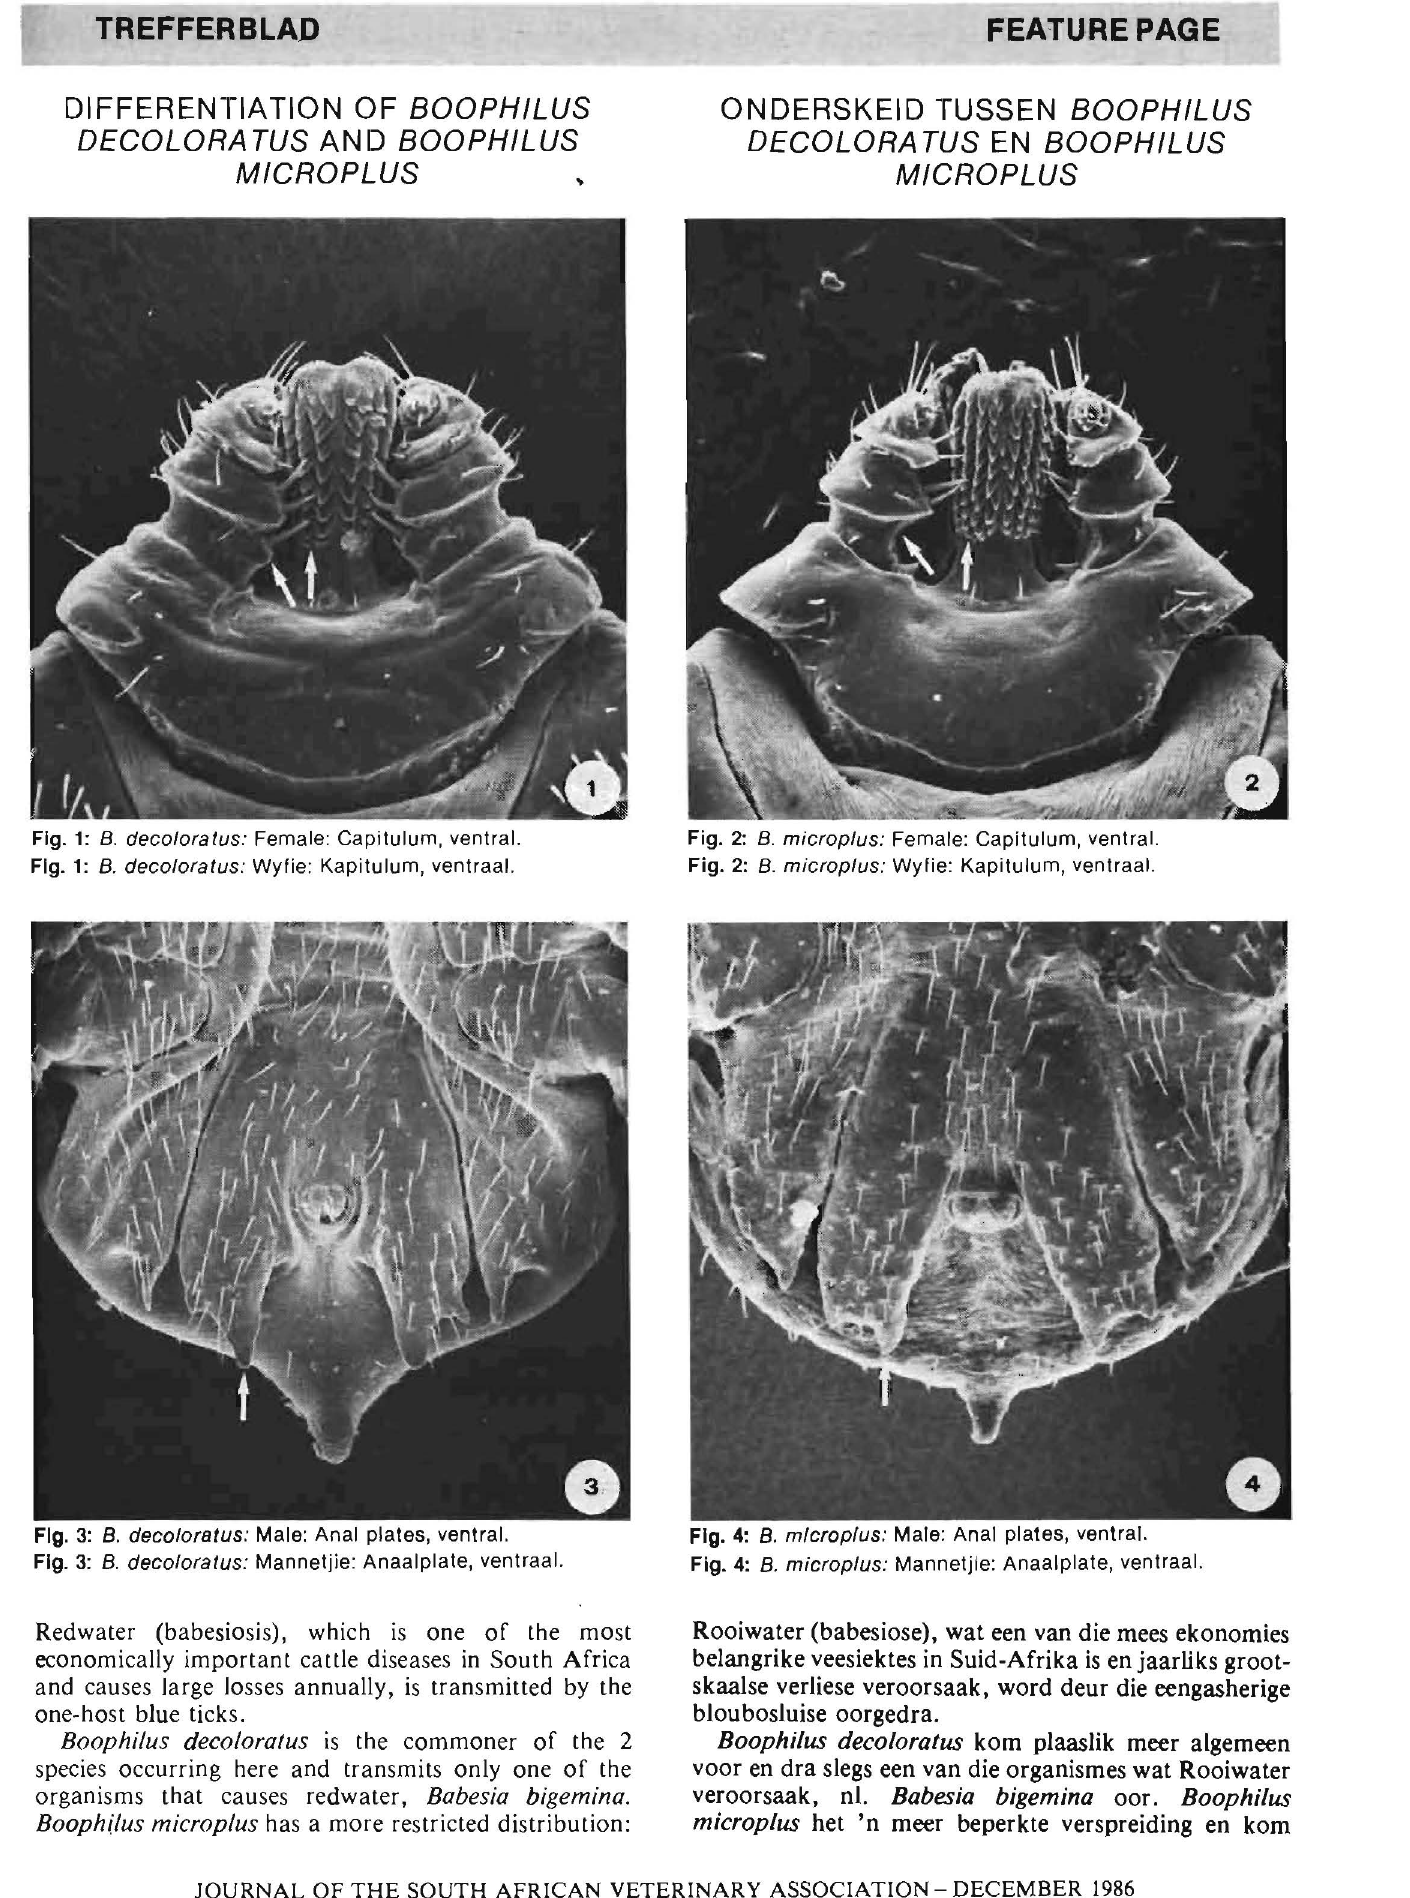
Fig. 3: B. dec%ra/us: Male: Anal plates, ventral. Fig. 3: B. dec%ra/us: Mannetjie: Anaalplate, ventraal.